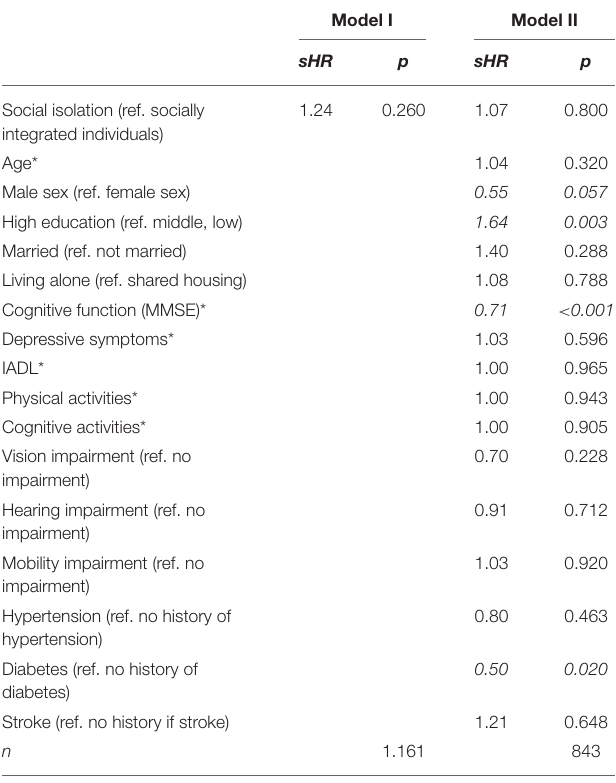
TABLE 2 | Univariate and multivariate Fine and Gray (competing risk) regression model for the impact of social isolation on incident